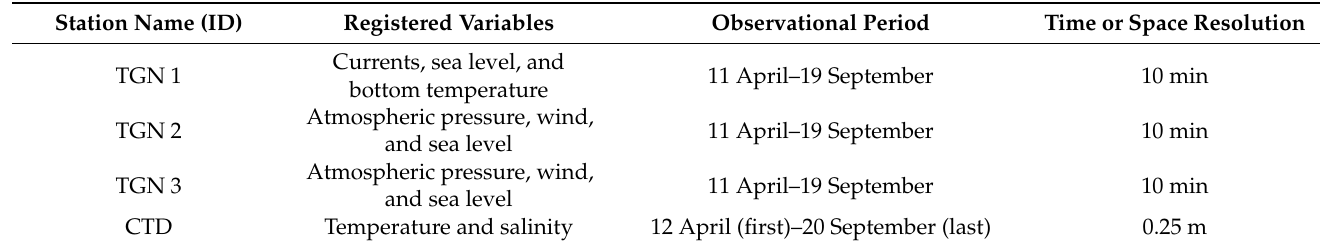
Table 3. Summary of measured data at the stations, shown in Figure 1, corresponding to the Tarragona harbour campaigns, indicating observation periods and data recording intervals.